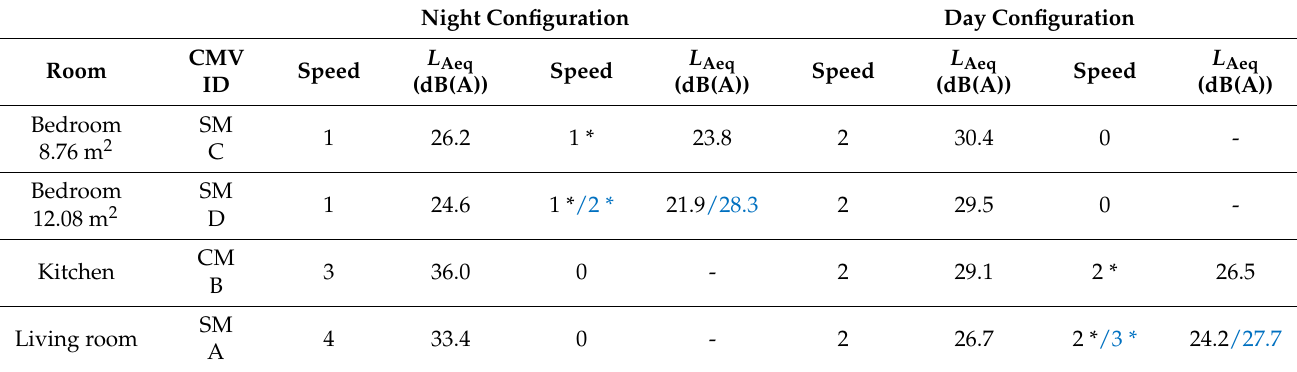
Table 10. Three-room apartment. Night and day configurations (in blue 0.5 1/h single operation CMV speed). Night Configuration